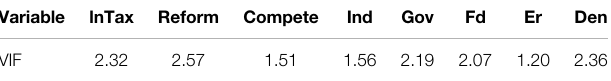
TABLE 5 | Empirical regression results. TABLE 6 | The test results of